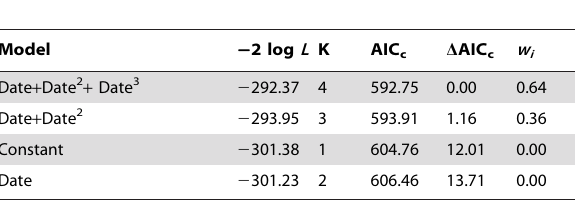
Table 2. Model selection results examining the potential relationship between the risk of nest predation and date during the breeding season for Dusky Flycatchers ( n =167) from 2006 to 2008, Lake Tahoe, California.